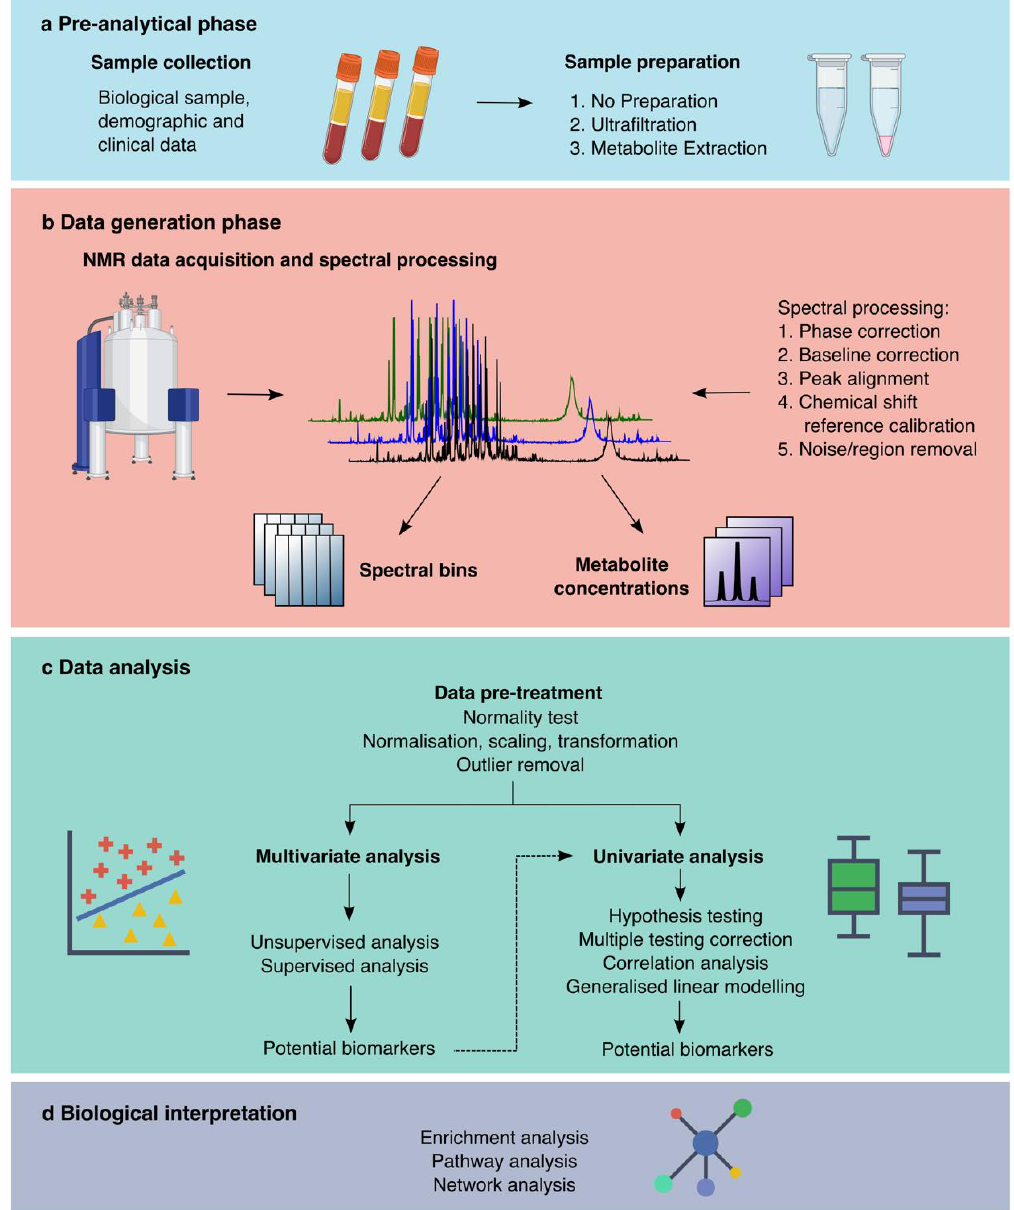
Figure 2. A typical workflow for untargeted NMR metabolomics. The NMR metabolomics workflow is divided into four main phases: ( a ) pre-analytical including sample collection and sample preparation, ( b ) data generation which involves NMR spectra acquisition, spectral processing, and the generation of spectral bins and/or metabolite concentrations. ( c ) Data analysis is performed for both data types including pre-treatment, multivariate and univariate analysis. The dashed arrow shows the optional integration of multivariate and univariate analyses. The fourth phase is ( d ) biological